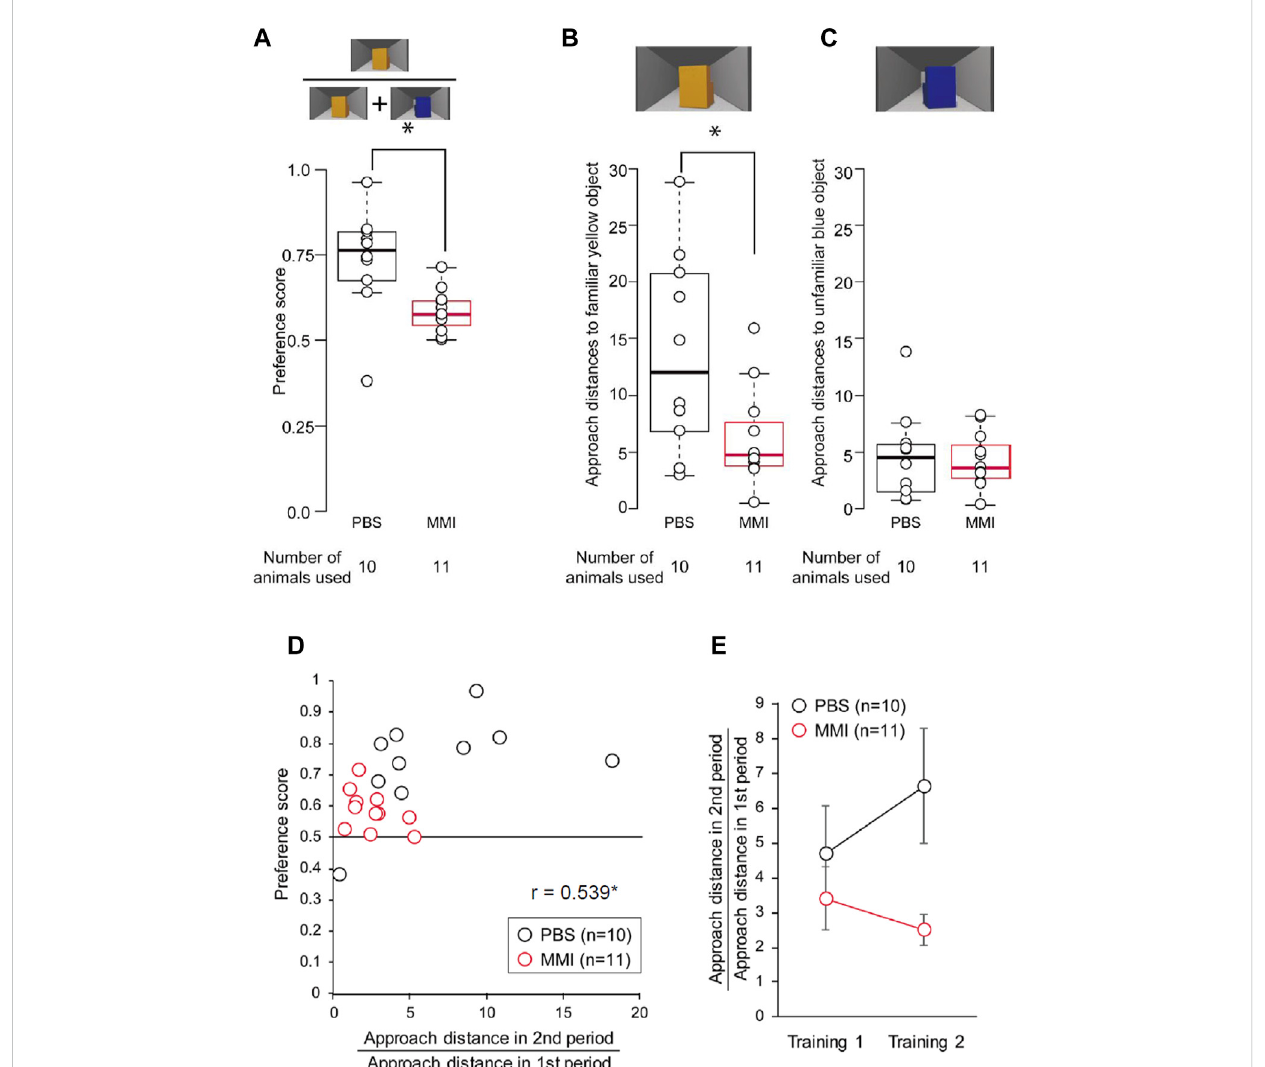
FIGURE 6 The behavior of phosphate-buffered saline (PBS)-administered and methimazole (MMI)-administered chicks during imprinting test. (A) Preference scores of the PBS-administered and the MMI-administered chicks in the imprinting test are shown. Preference scores of the MMI-administered chicks weresigni fi cantlylessthanthoseofthePBS-administeredchicks. (B) Approachdistancestothefamiliaryellowobjectareshown.Theapproachdistances to the imprinting object of the MMI-administered chicks were signi fi cantly less than those of the PBS-administered chicks. (C) The approach distances to the unfamiliar blue object are shown. The approach distances to the control object of the MMI-administered chicks were not signi fi cantly differentfrom thoseof thePBS-administeredchicks. (D) The scatter plots betweenthepreference score and approach distancein thesecond period are normalized by that in the fi rst period. Black dots indicate PBS-administered chicks. Red dots indicate MMI-administered chicks. (E) The normalized approach distance in the second period in the Training one and Training two are shown. Data represent mean ± SEM. The asterisks (*) indicate signi fi cance ( p <